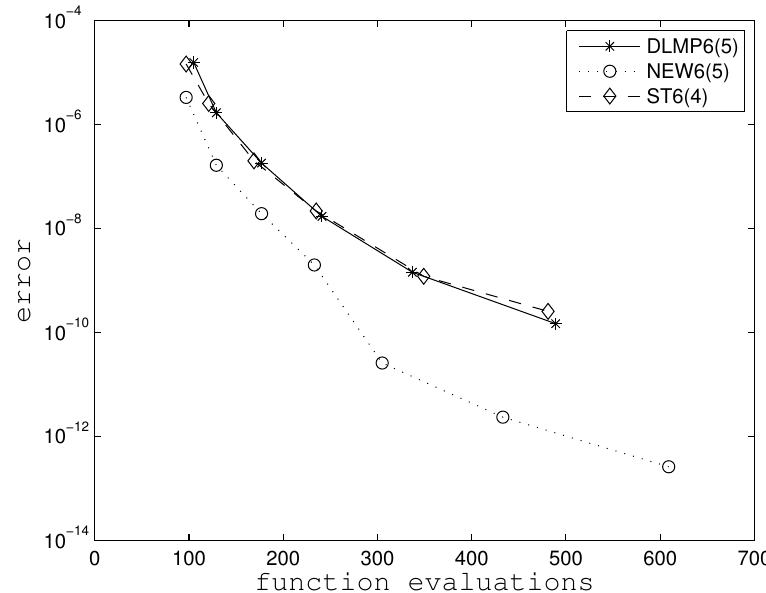
Figure 1. Efficiency plots for Problem–1.